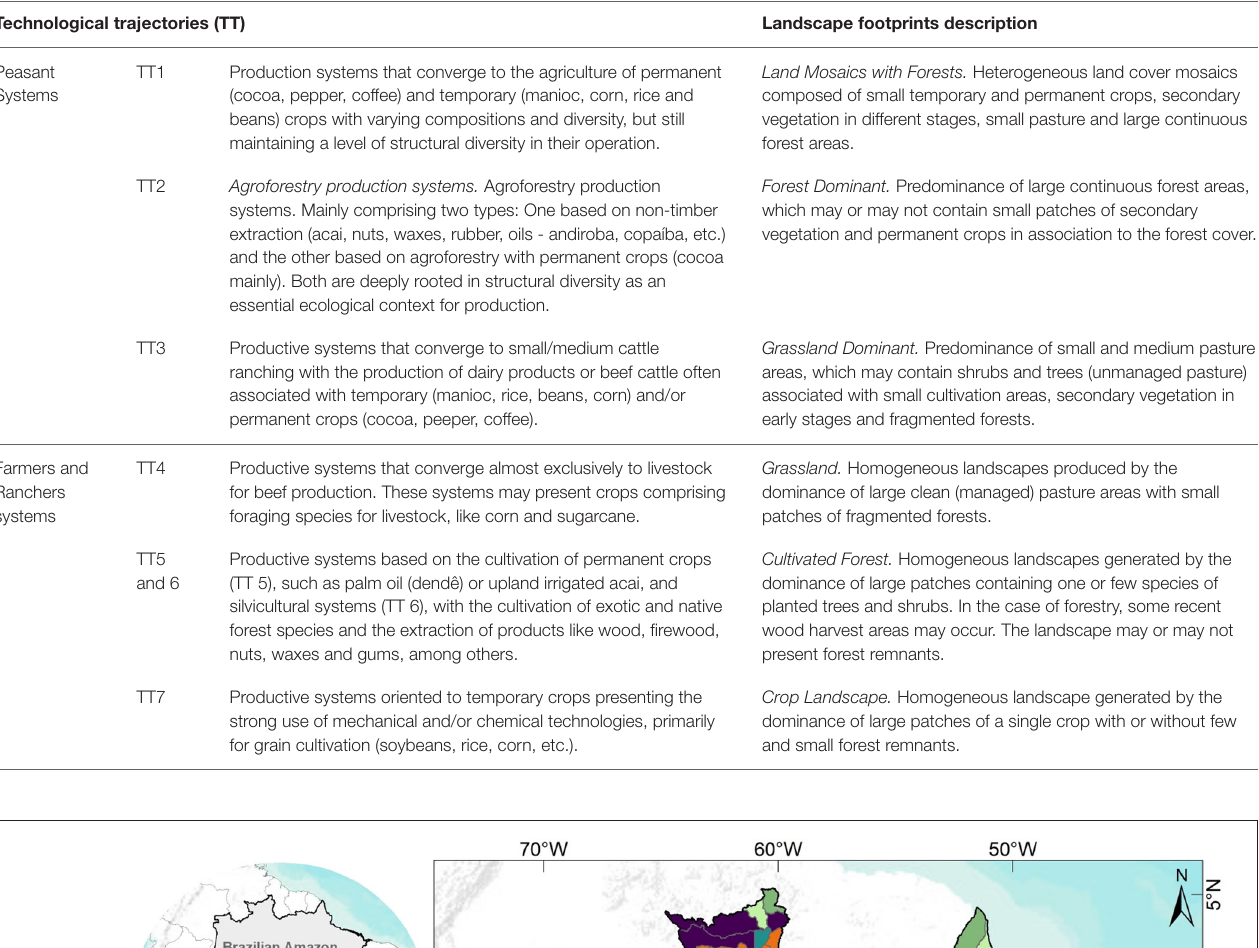
TABLE 1 | Technological Trajectories and their contemporary empirical forms of expression in the Amazon biome and their associated landscape structures. Technological trajectories (TT) Landscape footprints description